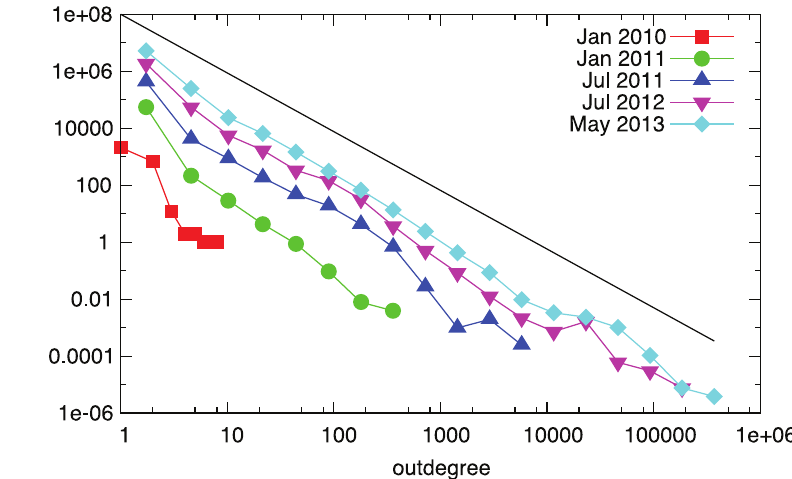
Figure 3. Evolution of the outdegree distribution. The black line shows a fitted power-law for the final network; the exponent is 2 : 06 . The data is log-binned for ease of visual inspection, the power-law is fitted on the original data [18].